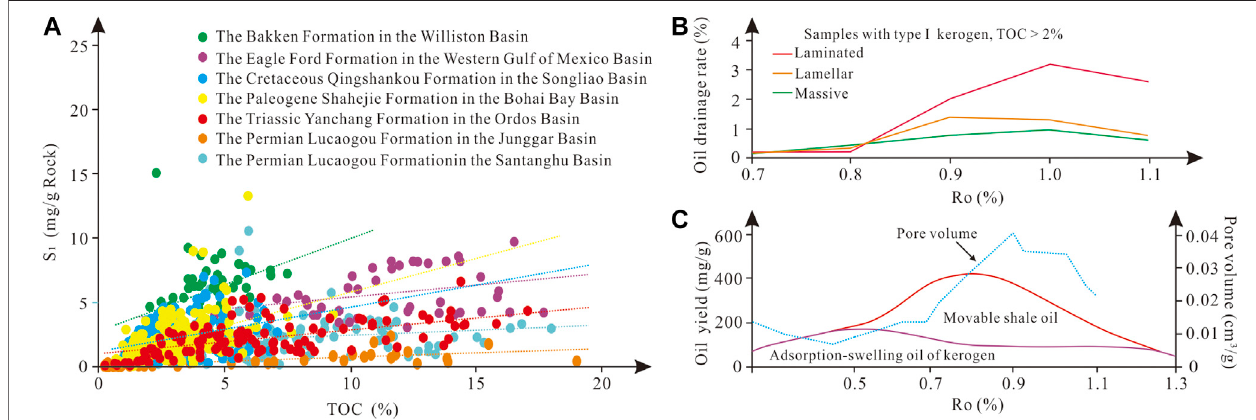
FIGURE6|(A) RelationshipbetweenoilcontentandTOCoforganic-richshale(datafromWangM.etal.,2015;LiX.N.etal.,2017;Huetal.,2018;Xuetal.,2019; Li C. R. et al., 2020). (B) relationship between lamina development and oil expulsion rate (modi fi ed from Wang Y. et al., 2016) (C) relationship between oil content and pore volume (modi fi ed from Zhao X. Z. et al.,